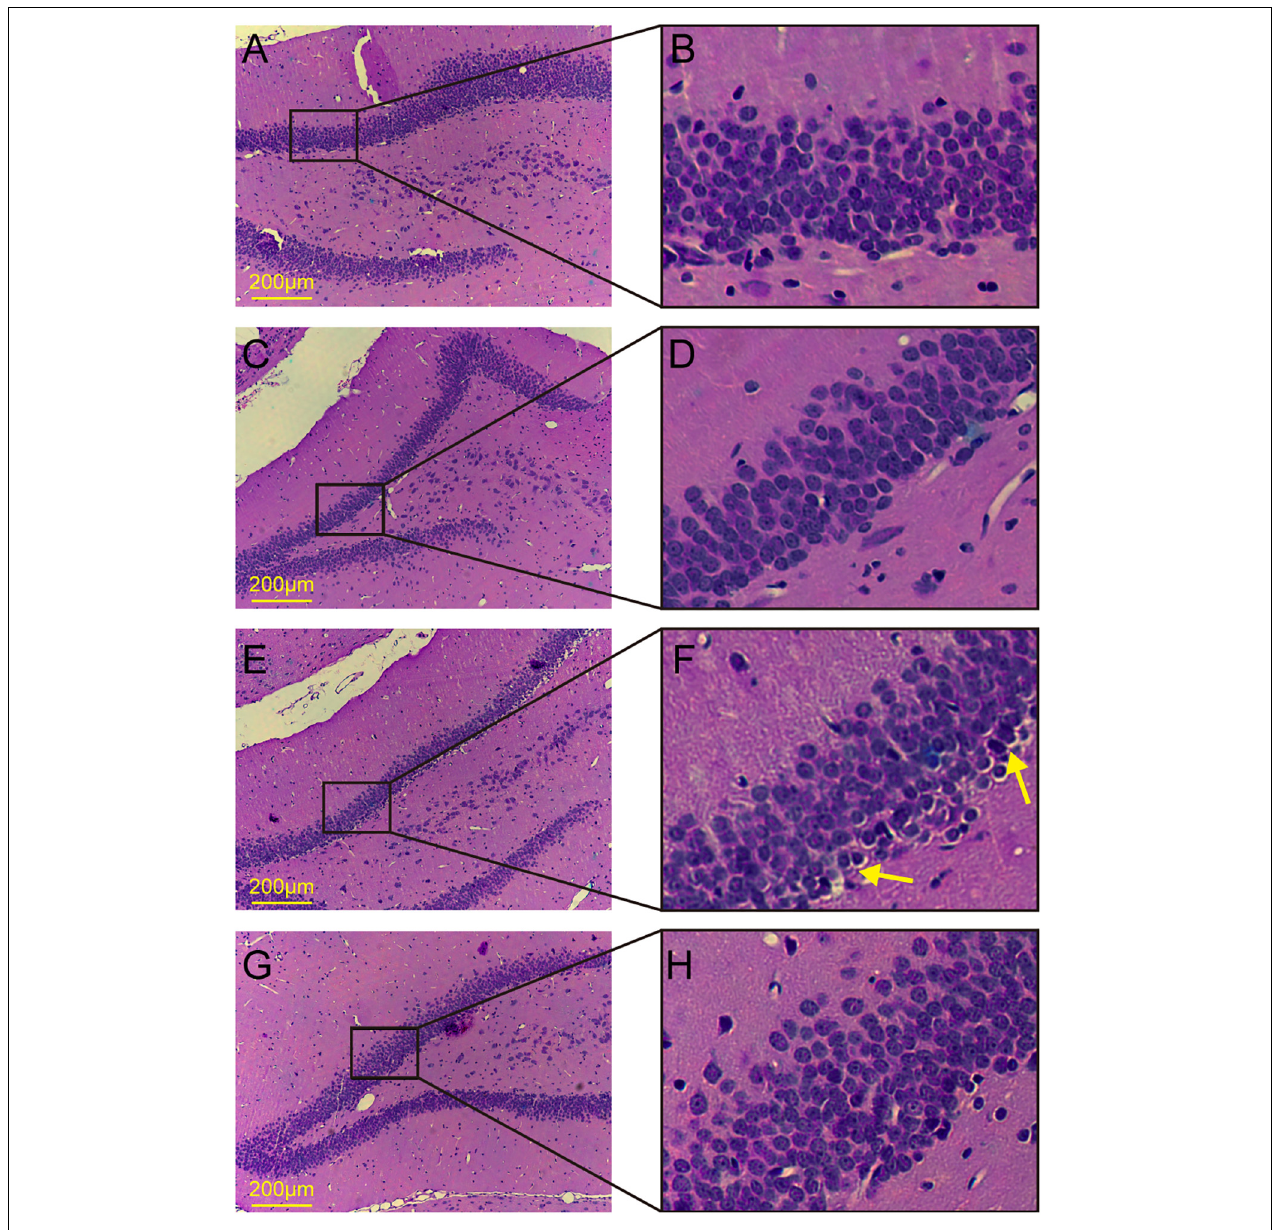
FIGURE 3 | HE staining of the dentate gyrus in the hippocampus. (A,B) Control group; (C,D) acute type 2 diabetes group; (E,F) chronic type 2 diabetes group; (G,H) astaxanthin